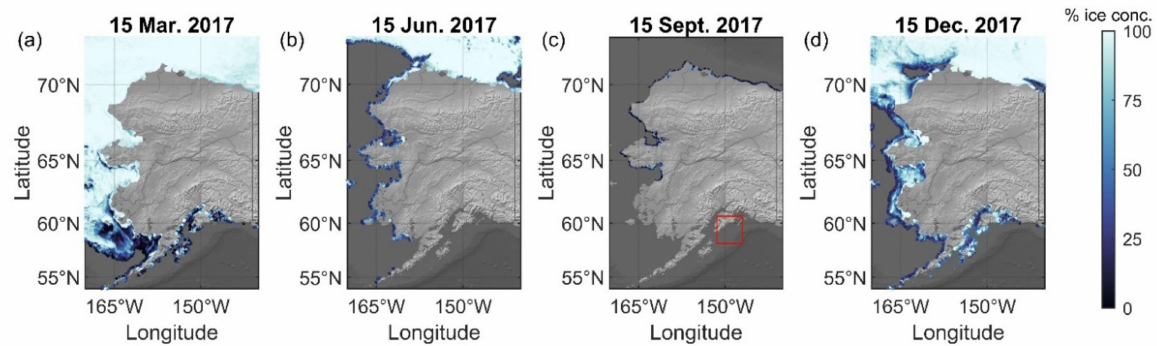
Figure 1. Sea ice concentration at four times of year in Alaska as measured by the Advanced Microwave Scanning Radiometer 2 (AMSR2) instrument. ( a ) Spring: 15 March 2017; ( b ) Summer: 15 June 2017; ( c ) Fall: 15 September 2017, with a red box outlining the study area of Prince William Sound; ( d ) Winter: 15 December 2017.